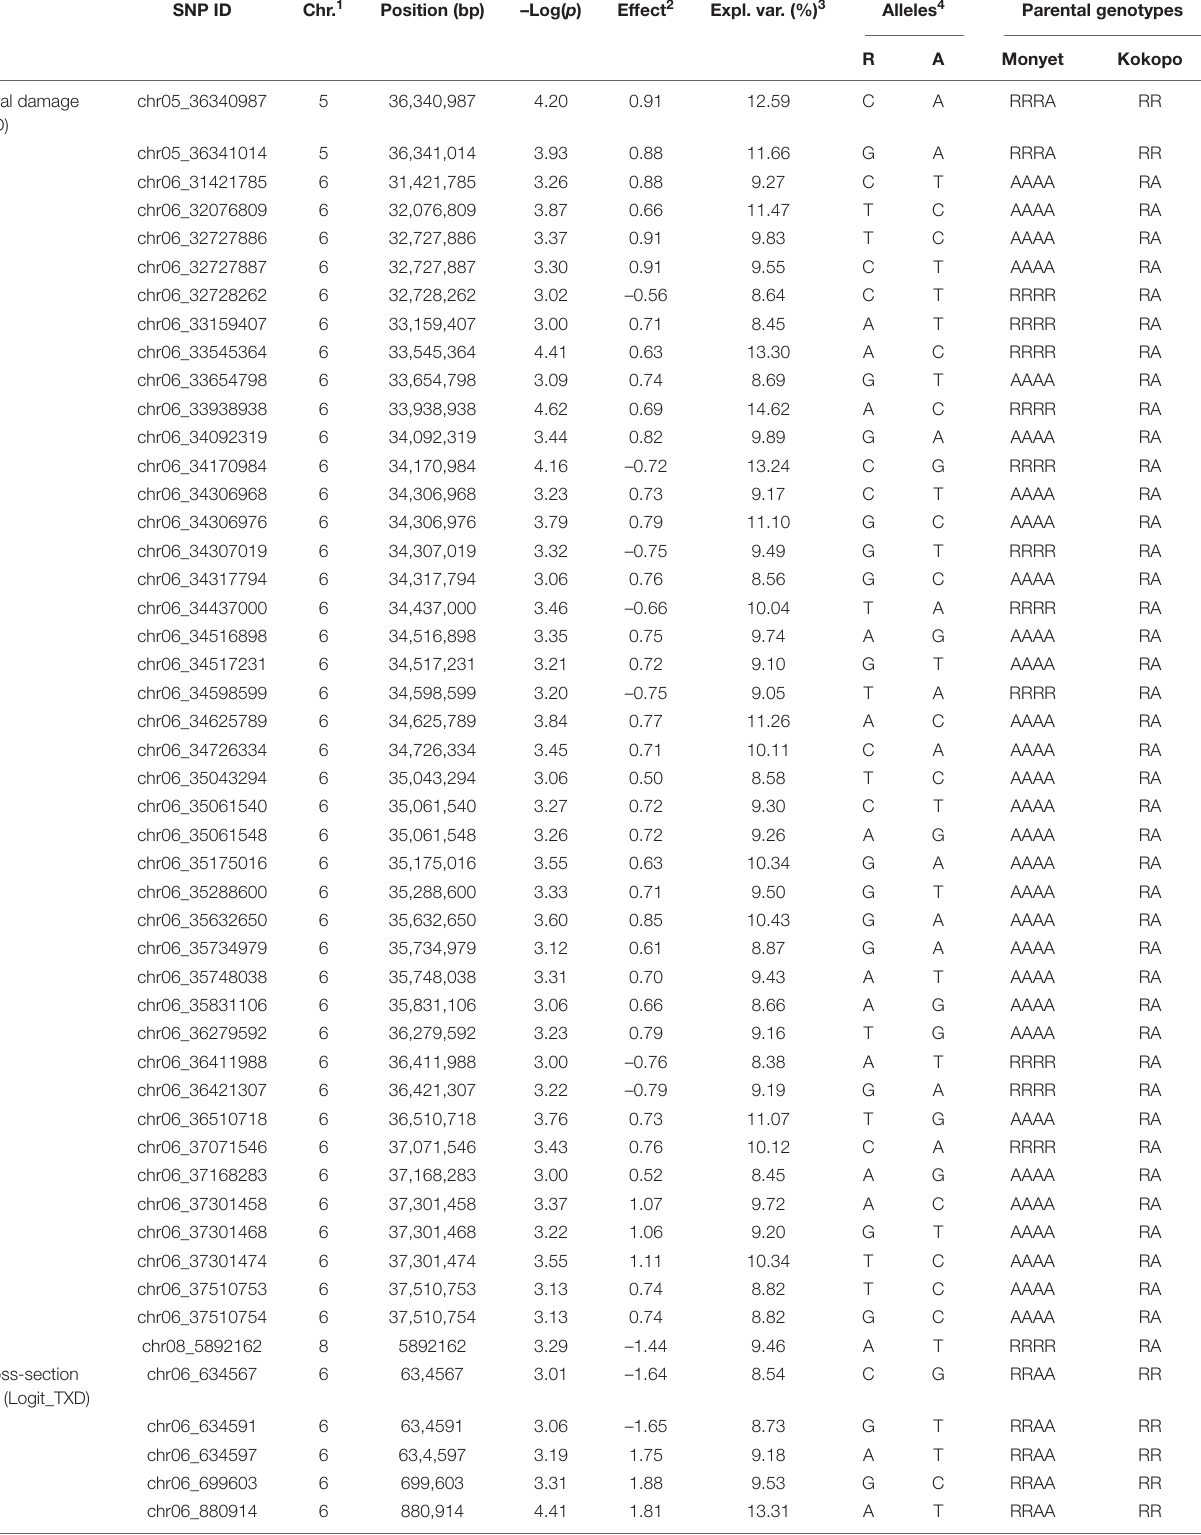
TABLE 3 | Single nucleotide polymorphism markers significantly associated with PD (Logit_PD) and TXD (logit-TXD) due to weevils at a significance level of α = 0.001 based on the continuous QTL mapping in a population of 138 triploid F 1 progeny derived from the “Monyet” × “Kokopo” cross having 18,009 SNP markers segregating. Trait SNP ID Chr. 1 Position (bp) –Log( p